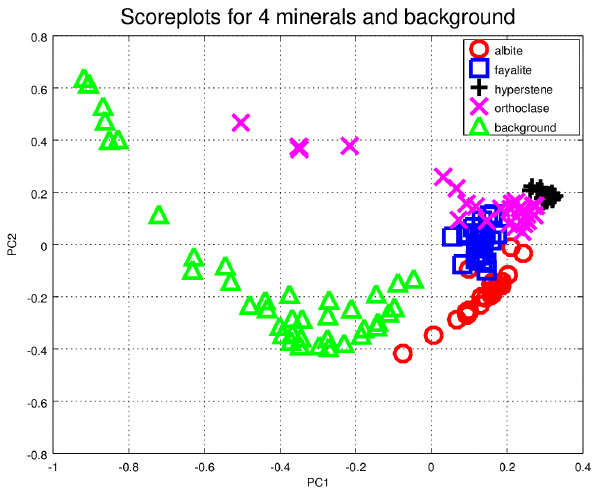
Figure 4. Score plot using the two first PCA components. The events represent the four minerals and the background for sub- strate SUB496. The scores from peak lists and RP results are es- sentially identical.